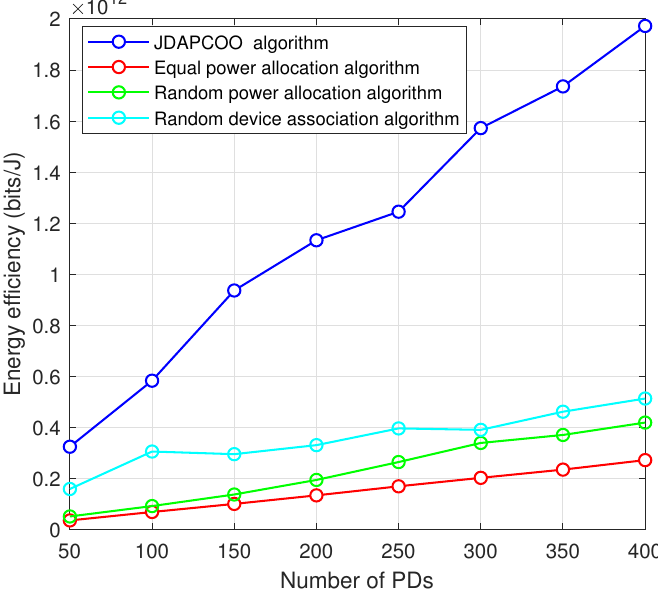
Figure 7. The relationship between the total system energy efficiency and the number of